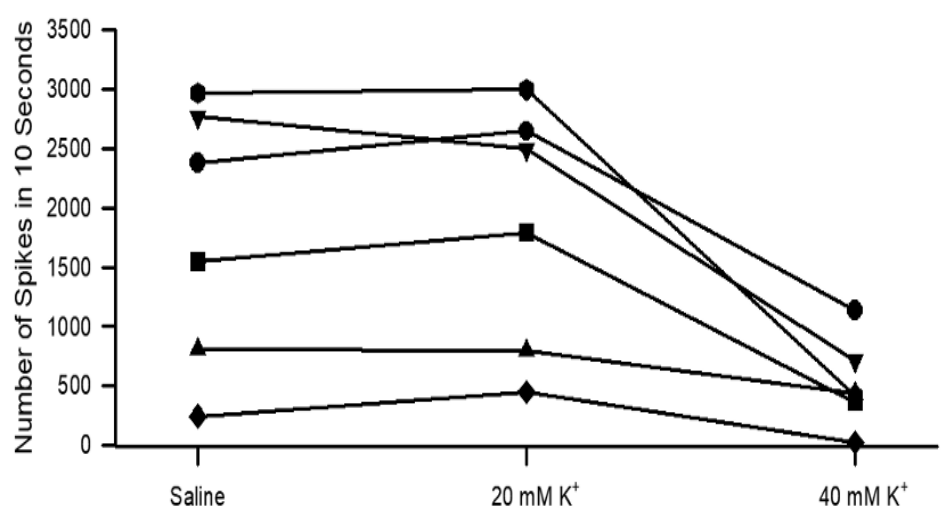
Figure 7. The number of spikes within 10 s when displacing the joint and holding it in a static position for six different preparations. There is no a significant effect for exposure to 20 mM K + but there is a significant decrease in activity when exposed to 40 mM K + ( p < 0.05 paired T-Test).